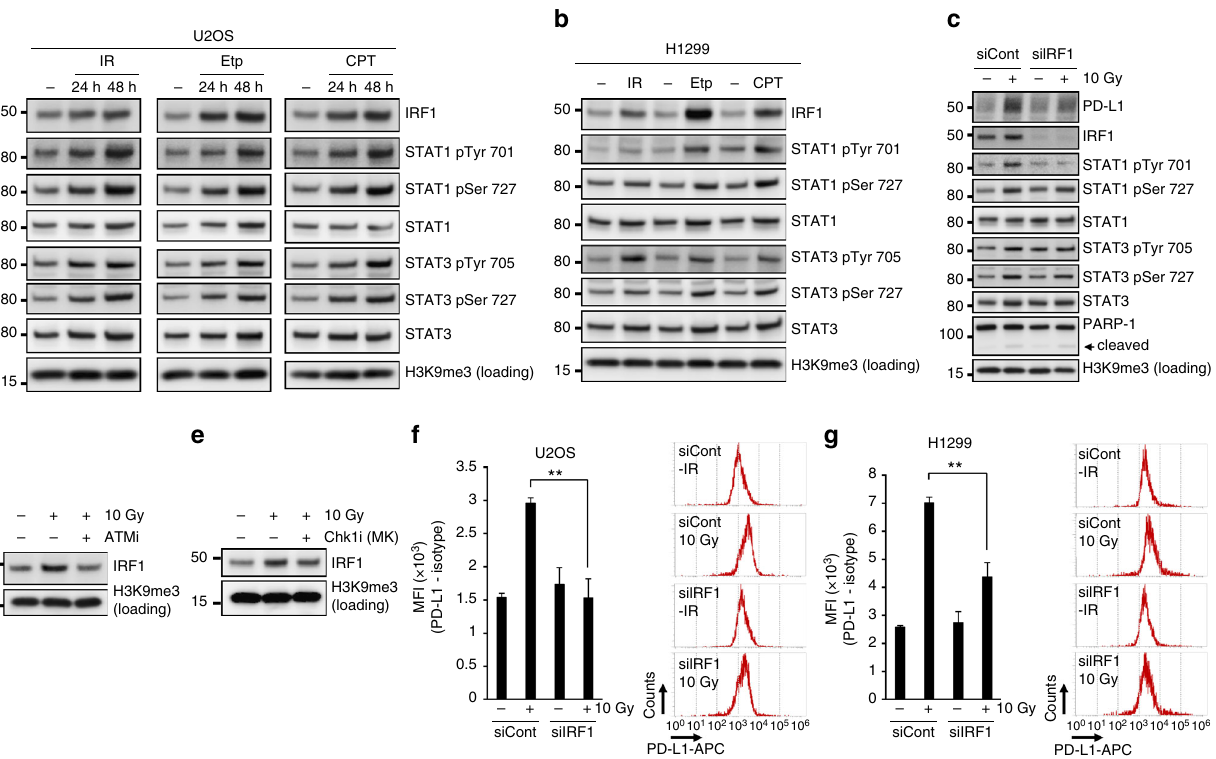
Fig. 6 DSB-dependent PD-L1 upregulation is mediated through IRF1 pathway. a , b DSBs activate STAT1/3 and IRF1 signalling. U2OS ( a ) or H1299 ( b ) cells were harvested after 10 Gy, 500 nM Etp or 50 nM CPT. c IRF1 is required for PD-L1 upregulation after IR. PD-L1 expression was examined in IRF1-depleted U2OS cells 48 h after 10 Gy. d , e ATM and Chk1 activities promote IRF1 upregulation after IR. IRF1 levels were examined with or without ATM ( d ) or Chk1 (MK8776) ( e ) inhibitor after 10 Gy. f , g Depletion of IRF1 signi fi cantly reduces the upregulation of cell-surface PD-L1 after IR. Cell-surface PD-L1 expression in IRF1-depleted U2OS ( f ) or H1299 ( g ) cells was examined by fl ow cytometry at 48 h after 10 Gy. A representative histogram is shown in the right panel. Error bars represent the s.d. of three independent experiments ( f , g ). Statistical signi fi cance was determined using Student ’ s two-tailed t -test. * P < 0.05, ** P < 0.01, *** P <